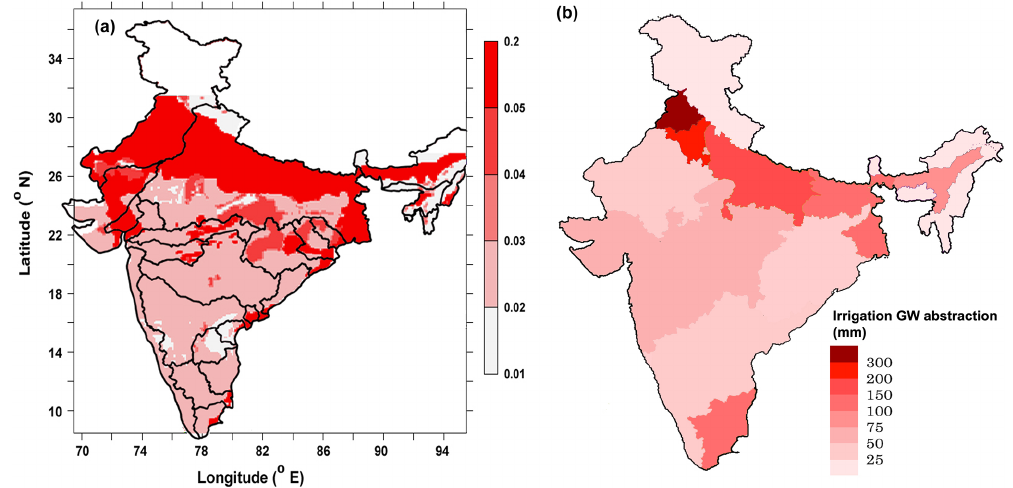
Figure 4. Maps of (a) specific yield data (modified from Bhanja et al., 2016). Blank areas represent areas of no data availability; (b) state-wide groundwater abstraction for irrigation (mm; estimates are for the year 2009; Central Ground Water Board, 2012).